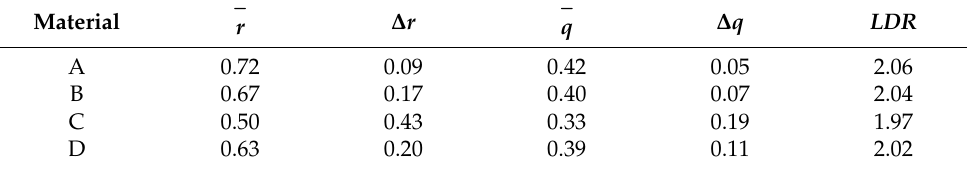
Table 1. Quantitative characteristics of plastic yielding in the investigated materials A–D.